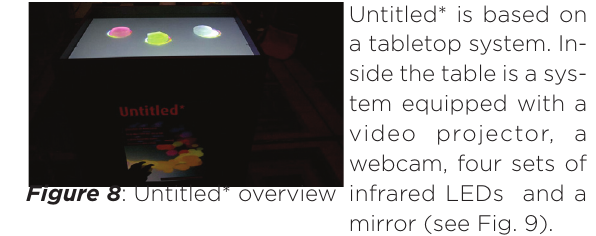
Untitled* is based on a tabletop system. In- side the table is a sys- tem equipped with a video projector, a webcam, four sets of infrared LEDs and a mirror (see Fig.